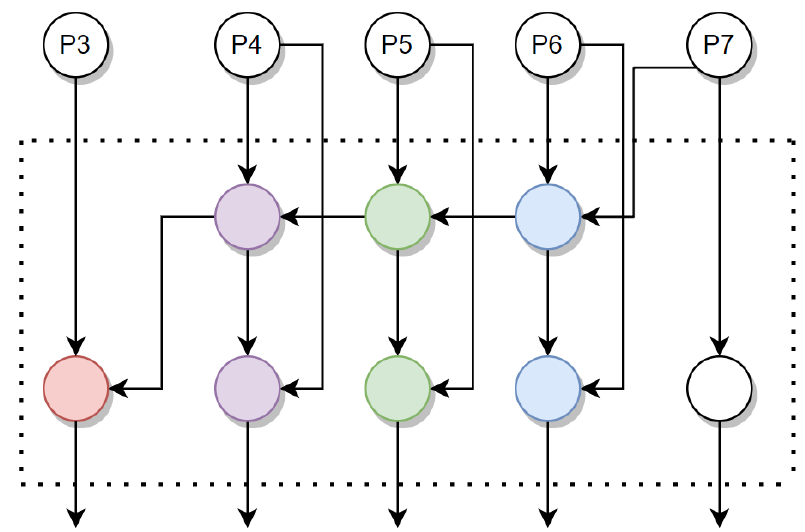
Figure 7. EfficentDet model architecture.